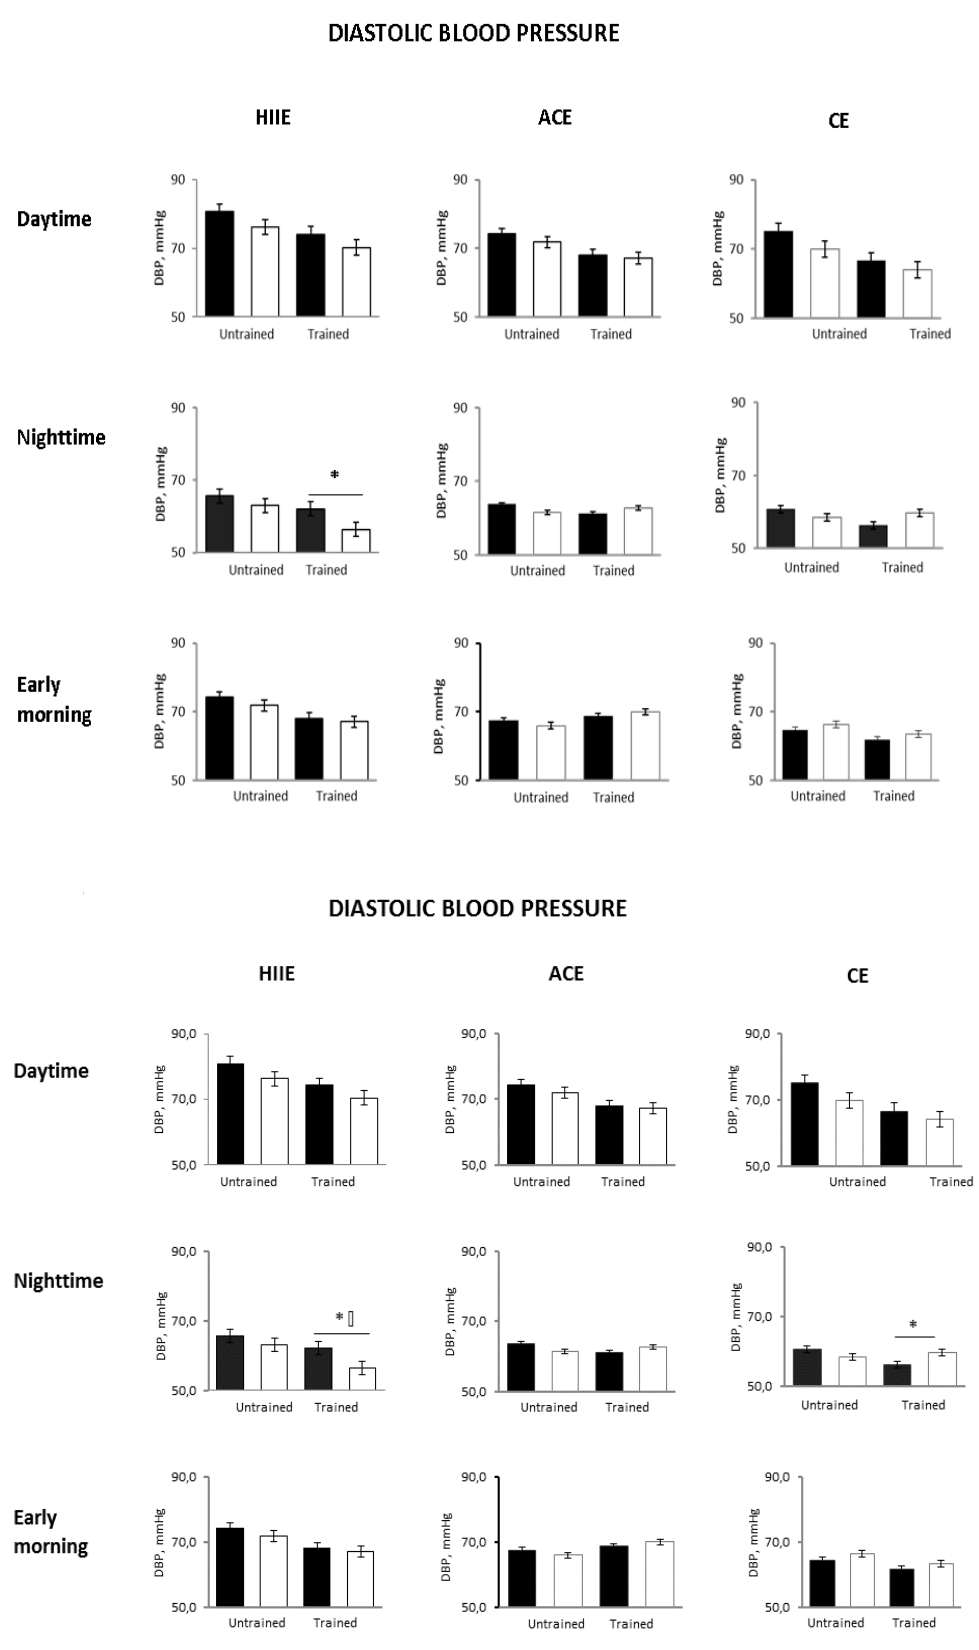
Figure 4. Post-exercise changes in ABPM diastolic BP in the three study groups in the different 24-h periods before (black bars) and after (white bars) a single exercise session in the untrained and trained status. HIIE, high intensity interval exercise; ACE, aerobic continuous exercise; CE, combined exercises * P<0.05 vs pre exercise.